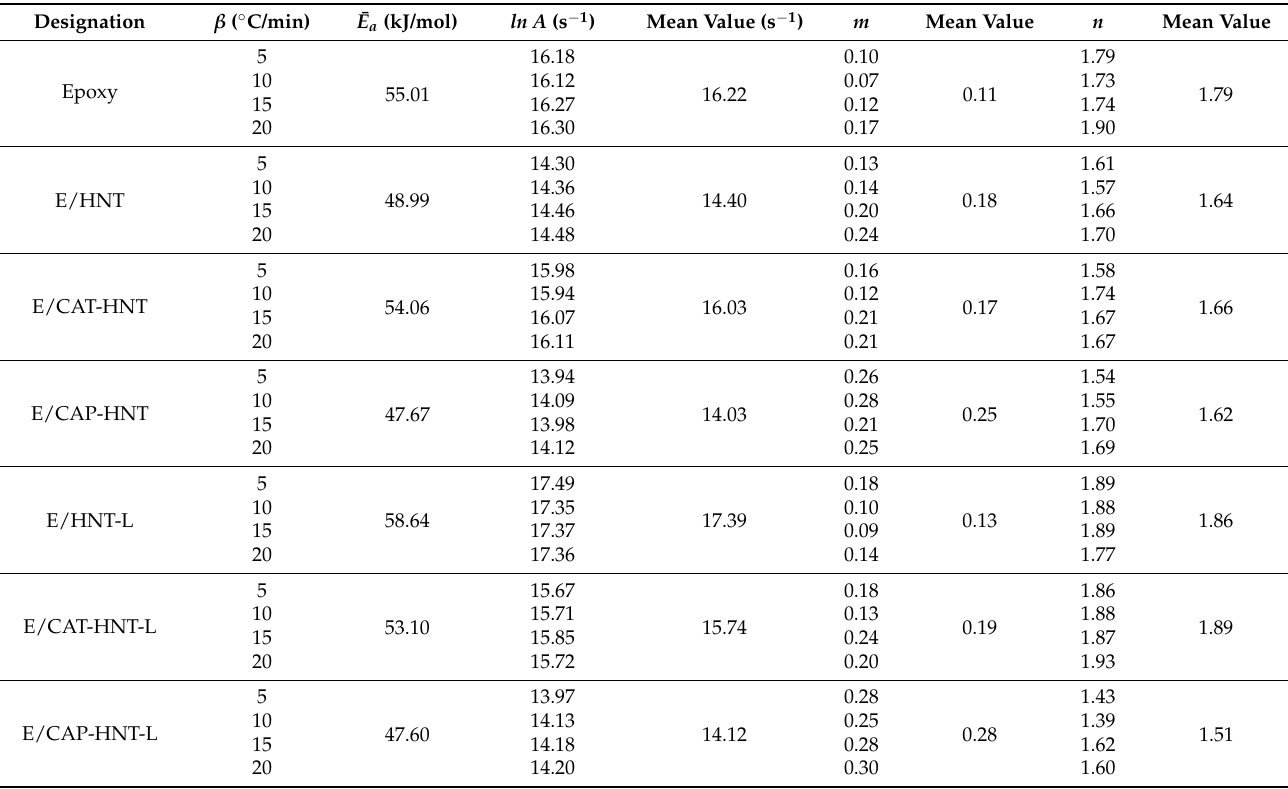
Table 3. Kinetic parameters of the studied systems obtained from Friedman model at different heating rates.